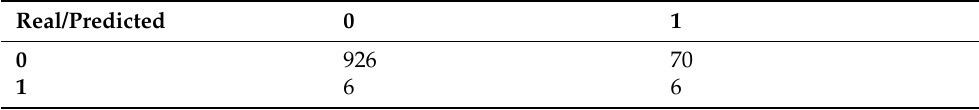
Table 5. Confusion Matrix